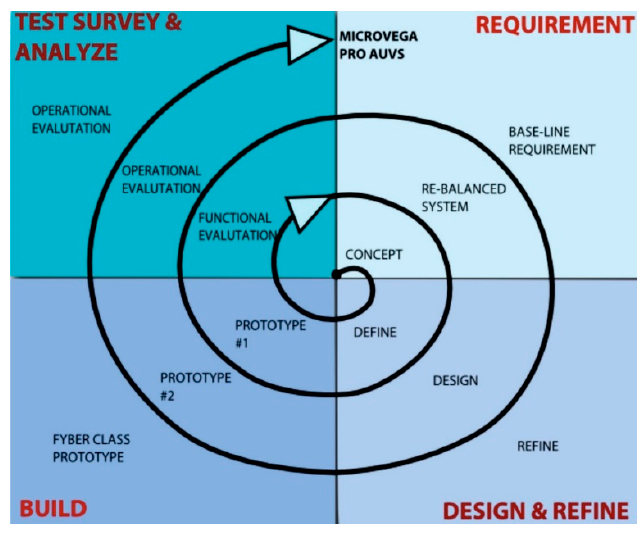
Figure 2. Spiral model of the project management.